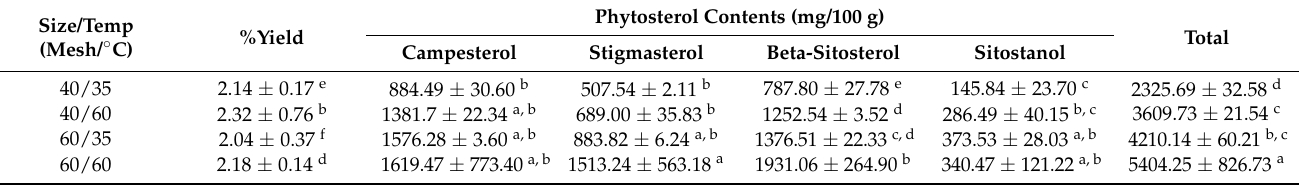
Table 2. Phytosterol contents of defatted rice bran extracted by SUBLDME with different sample sizes and extraction